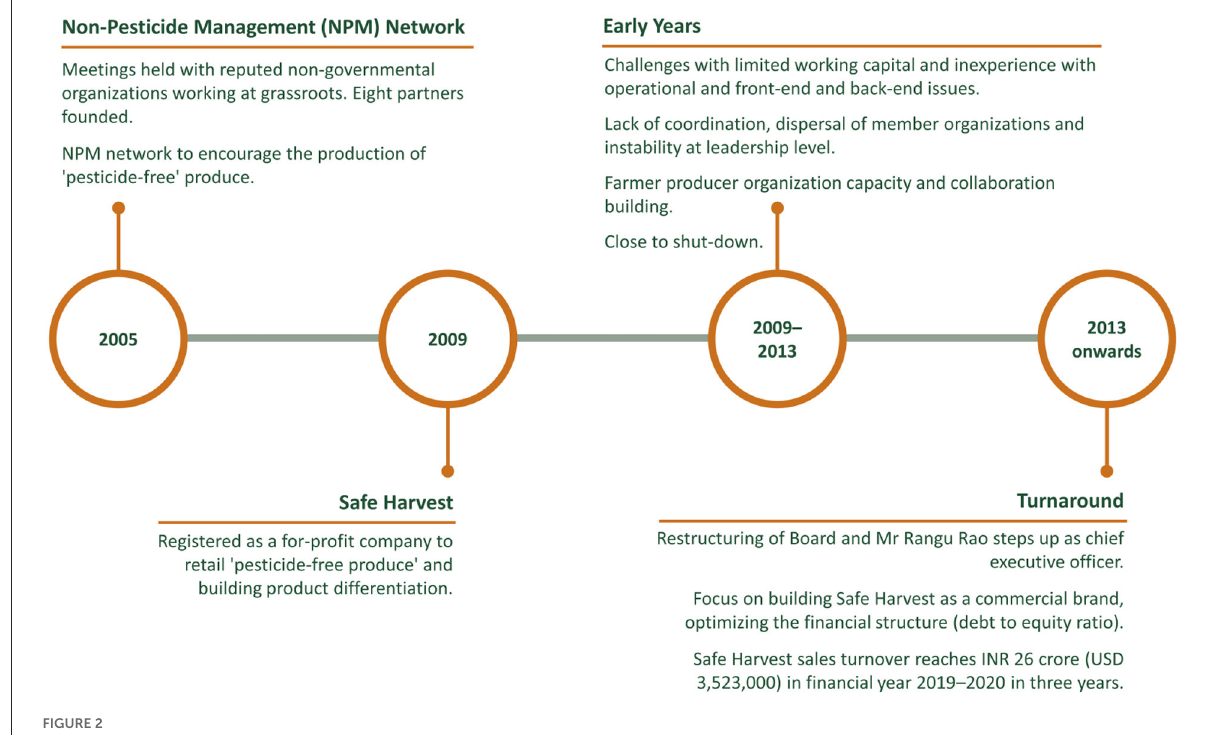
FIGURE2 Timeline of key events in Safe